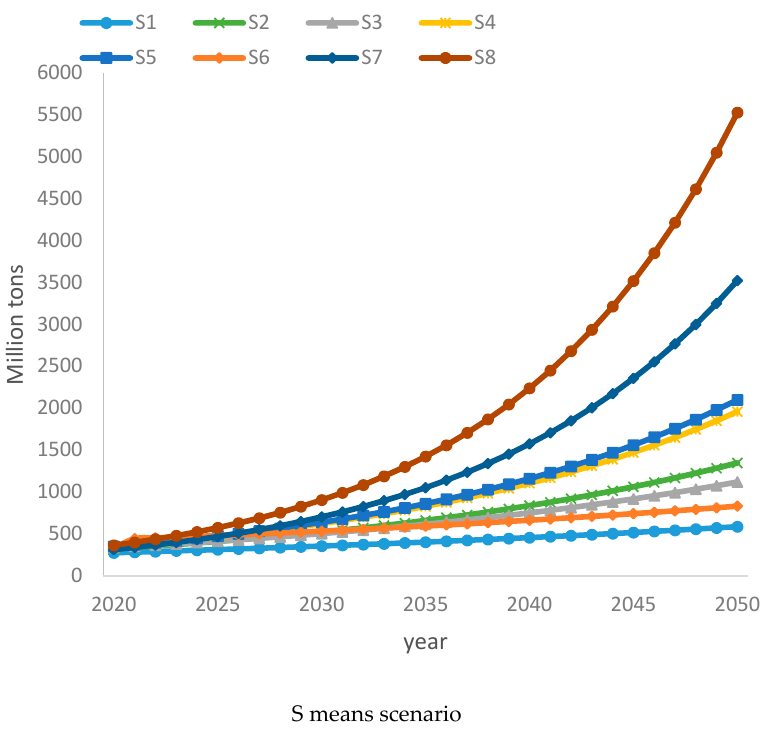
Figure 4. Prediction trends of carbon emissions in different scenarios. Table 11. Prediction of China ′ s energy consumption carbon emissions in different scenarios.